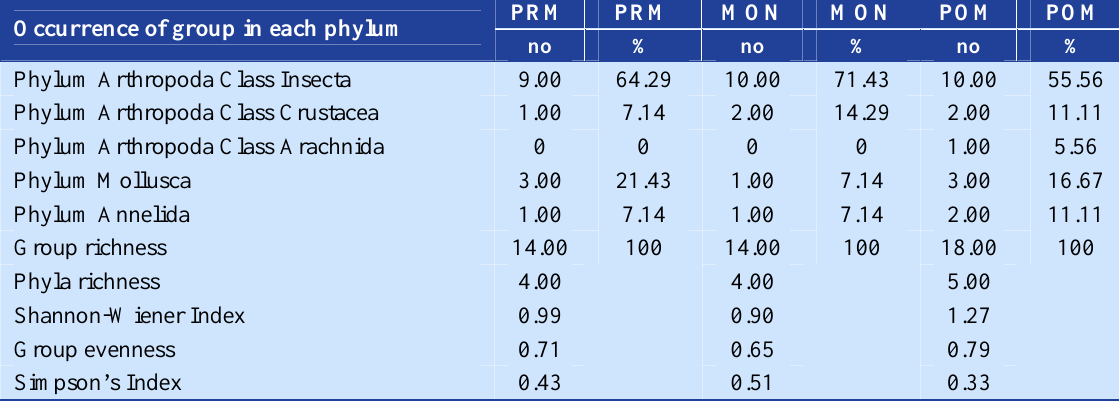
Table 3. Taxon frequency distributions and diversity indices of macroinvertebrates Occurrence of group in each phylum